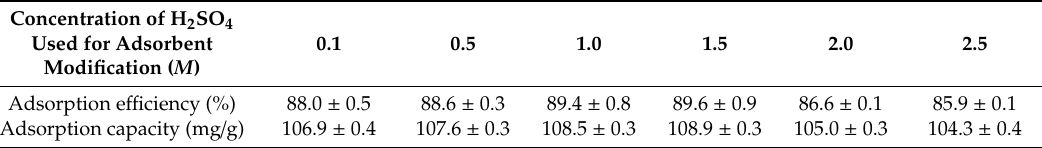
Table 1. The performance of various acid-modified sugarcane-bagasse-based adsorbents in removing microalgal biomass from eutrophic